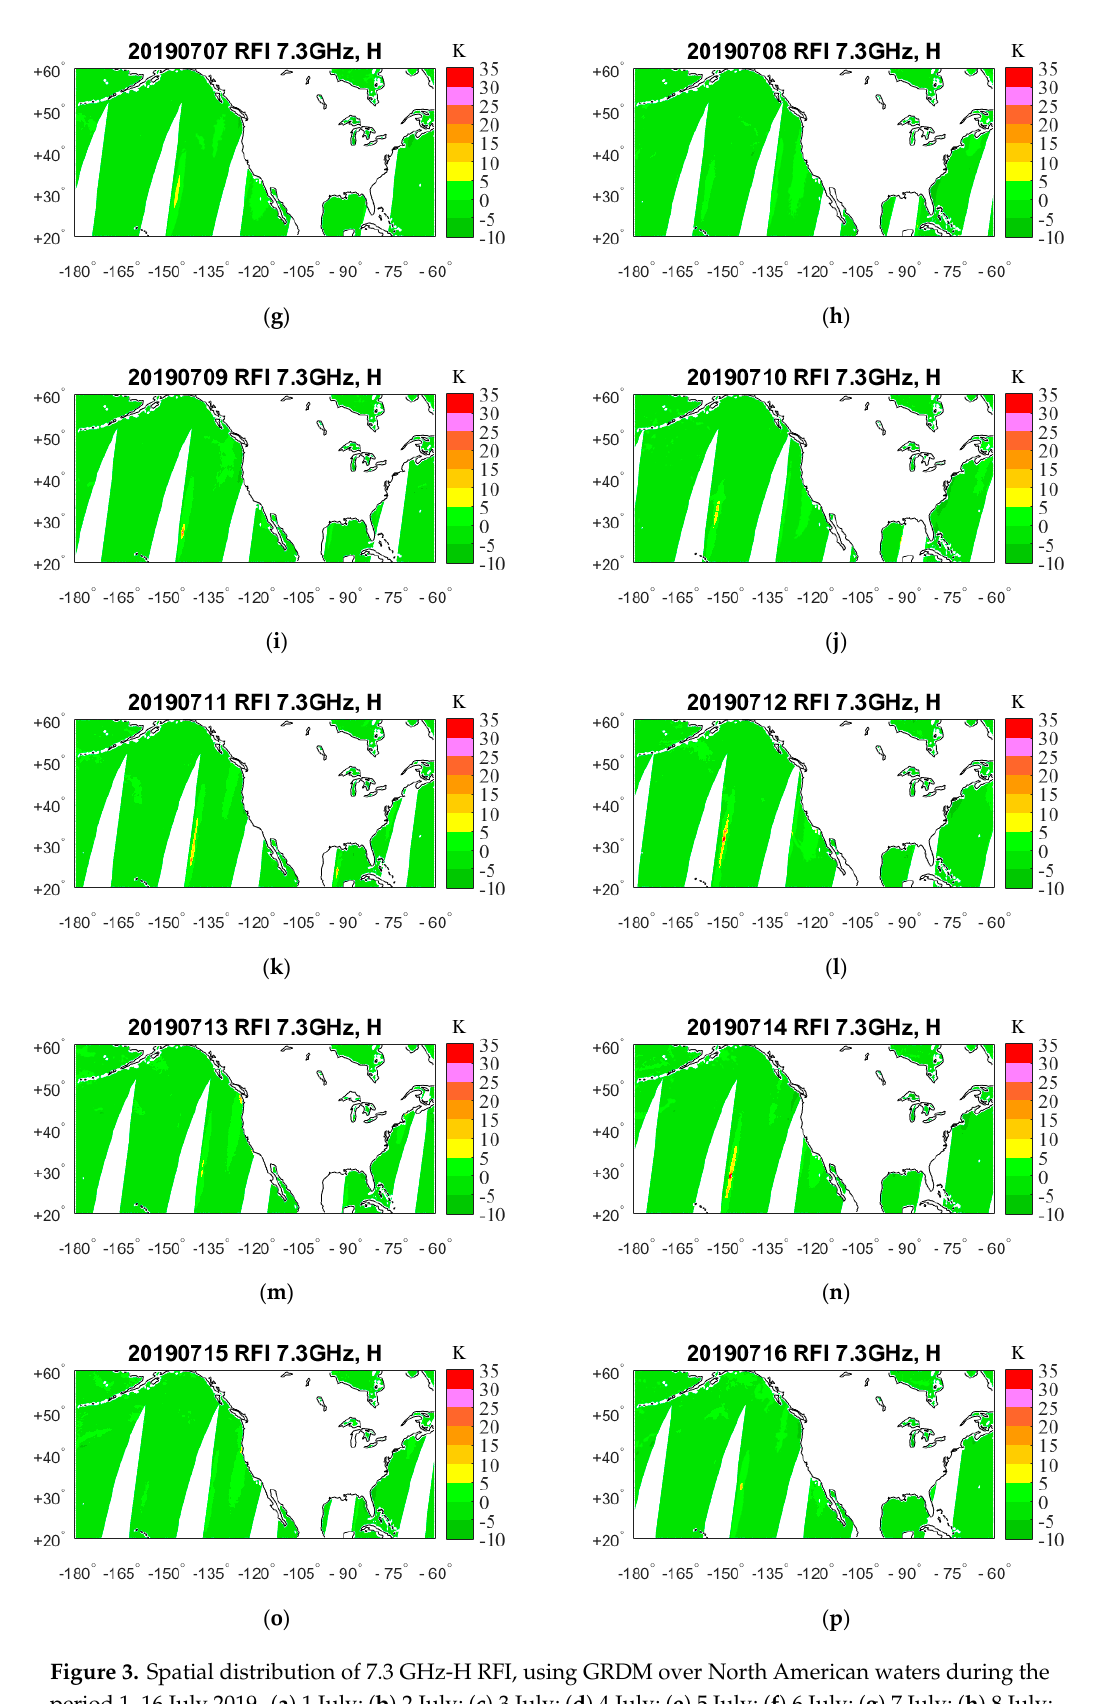
Figure 3. Spatial distribution of 7.3 GHz-H RFI, using GRDM over North American waters during the period 1–16 July 2019. ( a ) 1 July; ( b ) 2 July; ( c ) 3 July; ( d ) 4 July; ( e ) 5 July; ( f ) 6 July; ( g ) 7 July; ( h ) 8 July; ( i ) 9 July; ( j ) 10 July; ( k ) 11 July; ( l ) 12 July; ( m ) 13 July; ( n ) 14 July; ( o ) 15 July; ( p ) 16 July.